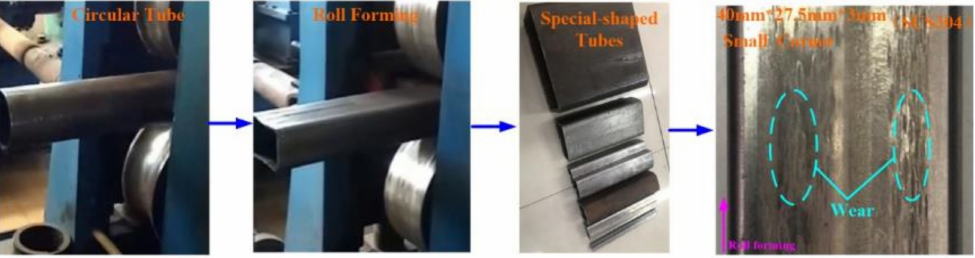
Figure 7. Roll forming